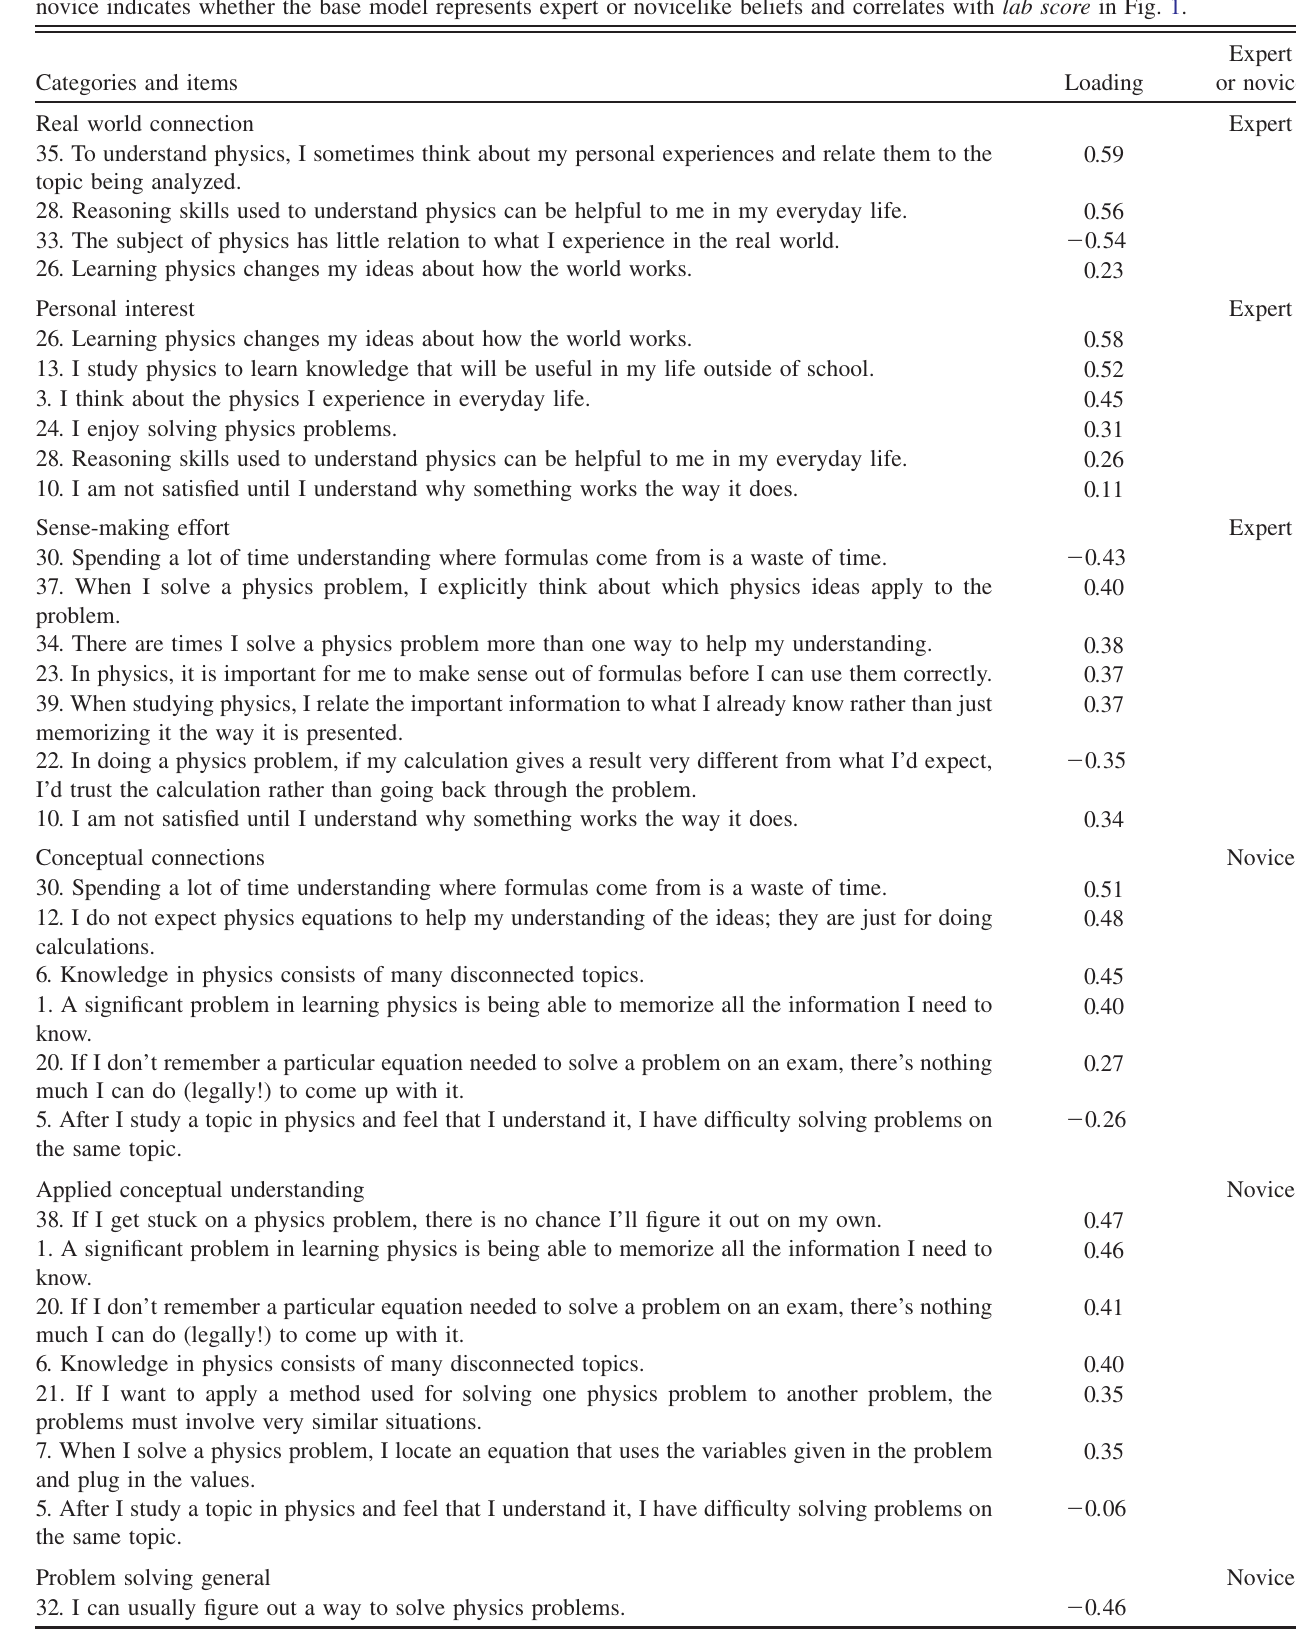
Expert or novice